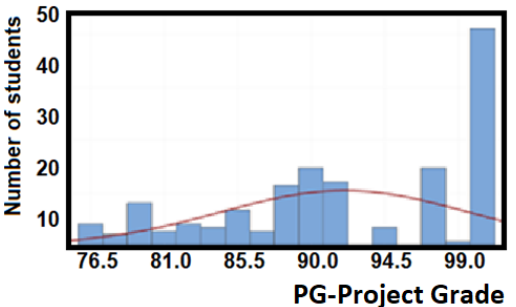
Figure 6. Statistics of project grade (PG) for the EFR competency.